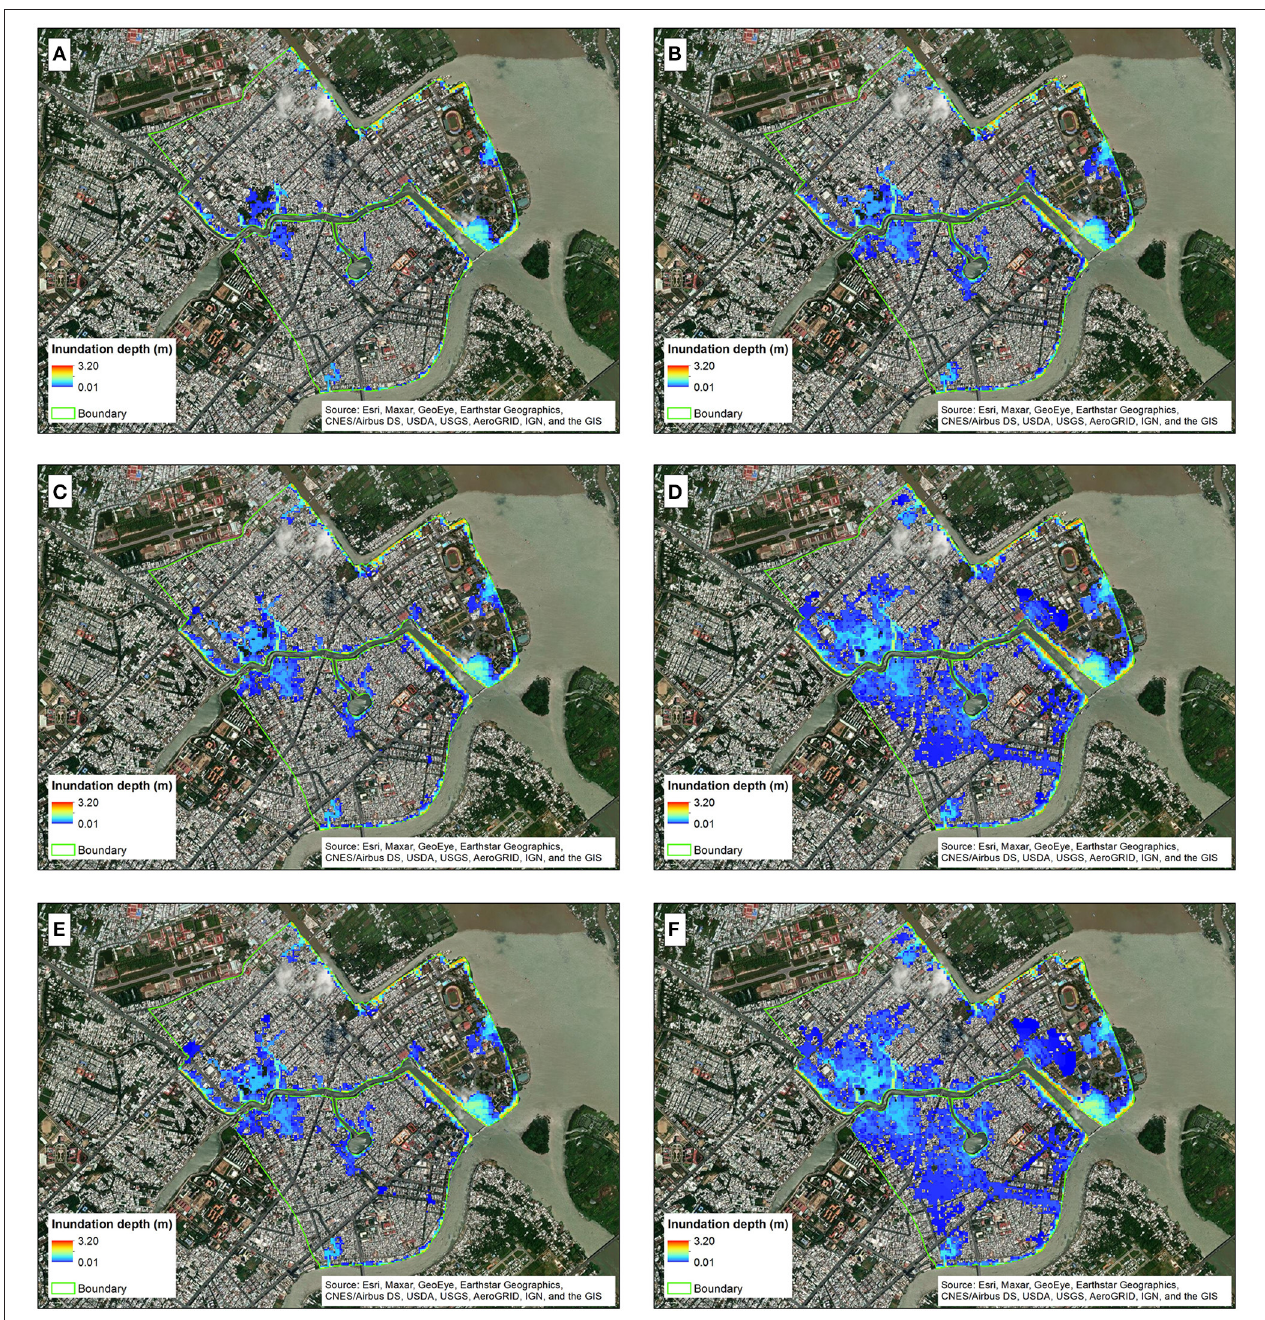
FIGURE 11 | Flood hazard maps corresponding to 5 year and 100 return period of water level for the present (model scenario #1) (A,B) , 2050 under RCP 4.5 (model scenarios #3) (C,D) , and RCP 8.5 (model scenarios #5) (E,F) , respectively.